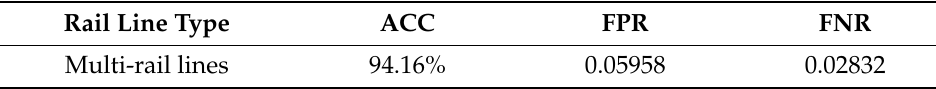
Table 4. The results of different type of rail lines on RAWRail.